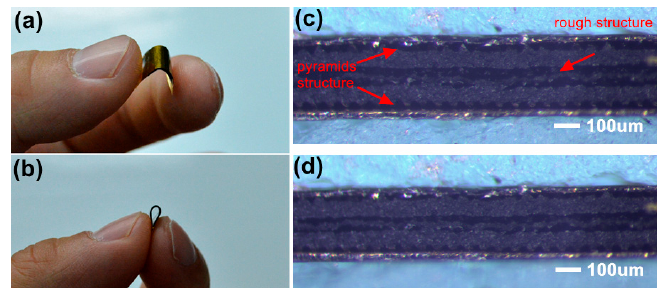
Figure 6. Optical images of the tactile sensor with ( a ) good flexibility showing ( b ) the bending limit. Optical images of the cross-section of the tactile sensor under ( c ) the initial state and ( d ) the compressive stress.